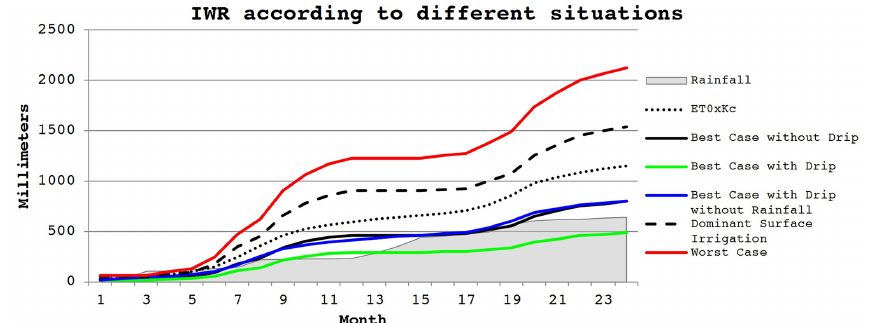
Figure 8. IWR G according to different efficiencies for 2 years of example (September 2011 to August 2013) in the case of an irrigated wheat. In the best case without drip curve, all coefficients are set to one except the efficient rainfall, which is set to a classical 0.75 ( σ = 1, ϕ = 1, α = 0.75, β = 1). In the best case with drip, The σ coefficient of localized irrigation is set to 0.7 ( σ = 1, ϕ = 0.7, α = 0.75, β = 1). The best case with drip but without taking into account rainfall simulates the irrigation practice done to prevent soil leaching ( σ = 1, ϕ = 0.7, α = 0, β = 1). The dominant surface irrigation simulates an irrigated sector where surface (gravity) irrigation dominates ( α = 0.5) and where the system performance is good ( σ = 0.9) ( σ = 0.9, ϕ = 1, α = 0.9, β = 0.5). The worst case depicts an irrigated sector with low irrigation efficiencies ( σ = 0.75, ϕ = 1, α = 0.75, β =